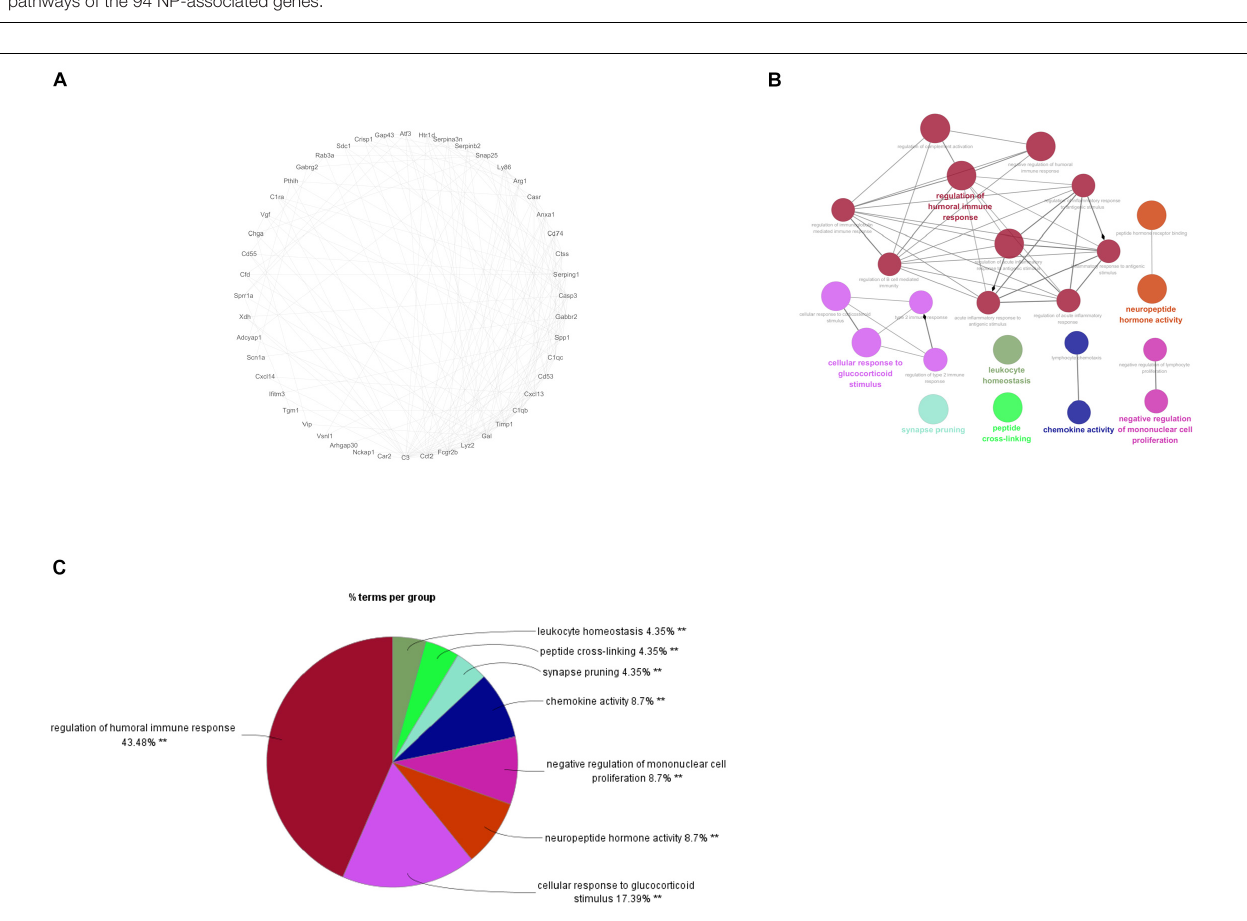
FIGURE 3 | PPI Network Analysis and identification of hub genes. (A) PPI network for the 48 genes involved in the functional module of a highest score; (B) : the most enriched GO terms for the 48 genes; C: Proportional graph of the enriched GO terms of the 48 genes.